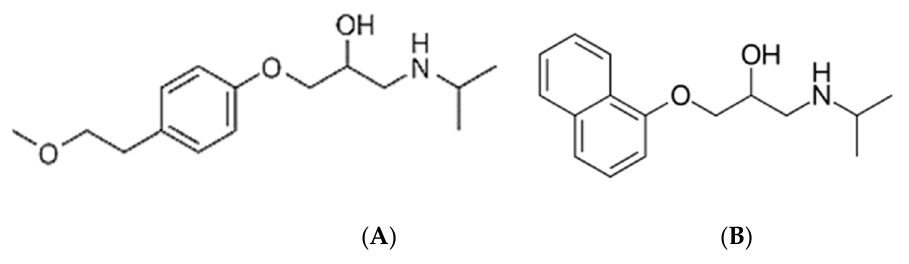
Figure 1. β -blockers ( A ) metoprolol, ( B ) propranolol. Figure 1. β ‑blockers ( A ) metoprolol, ( B )